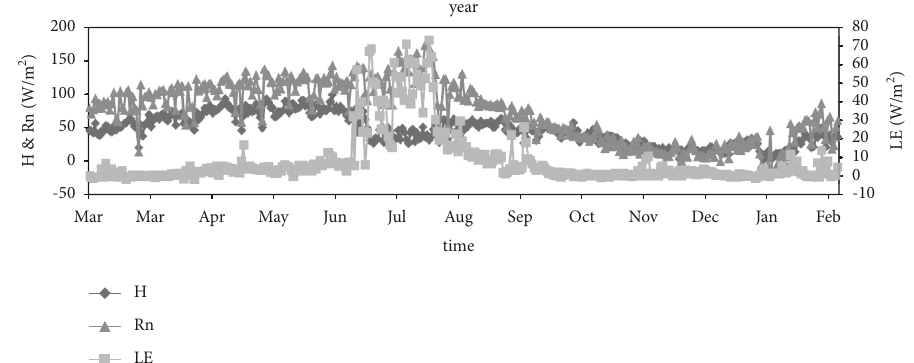
Figure 2: The daily variation characteristics of the sensible heat, latent heat, and net radiation fluxes.